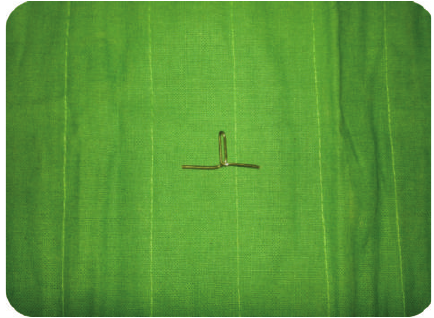
Figure 6: Fabrication of post core: procedure in Figure 5 repeated with the other